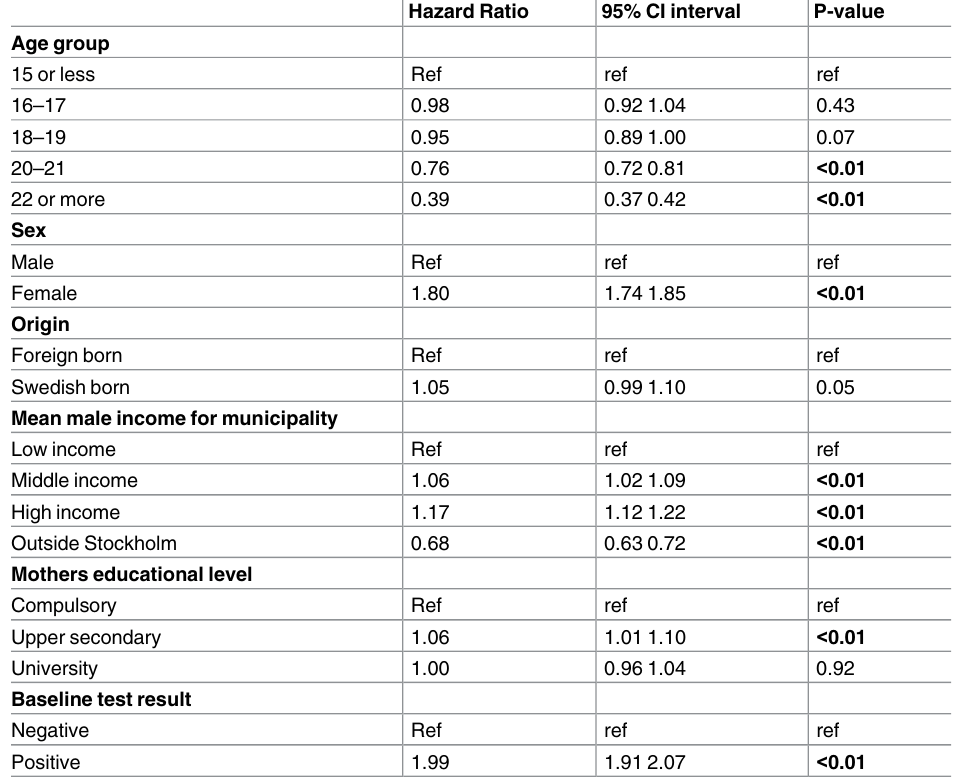
Table 3. Cox regression model, risk of re-testing for C . trachomatis among youth at the YHC in Stock- holm County